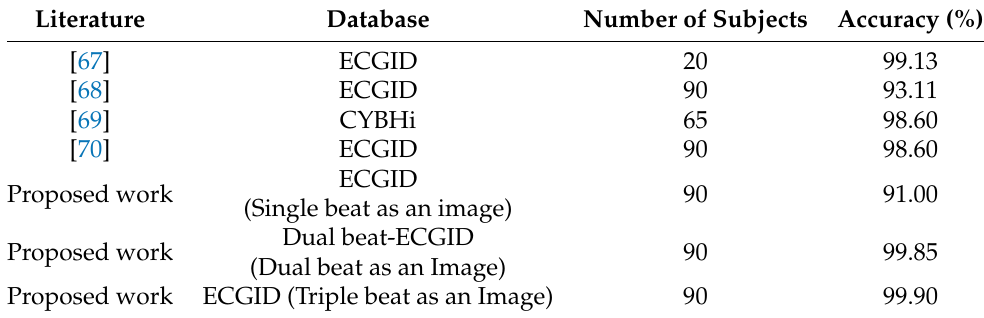
Table 11. Performance comparison of the proposed approach with similar